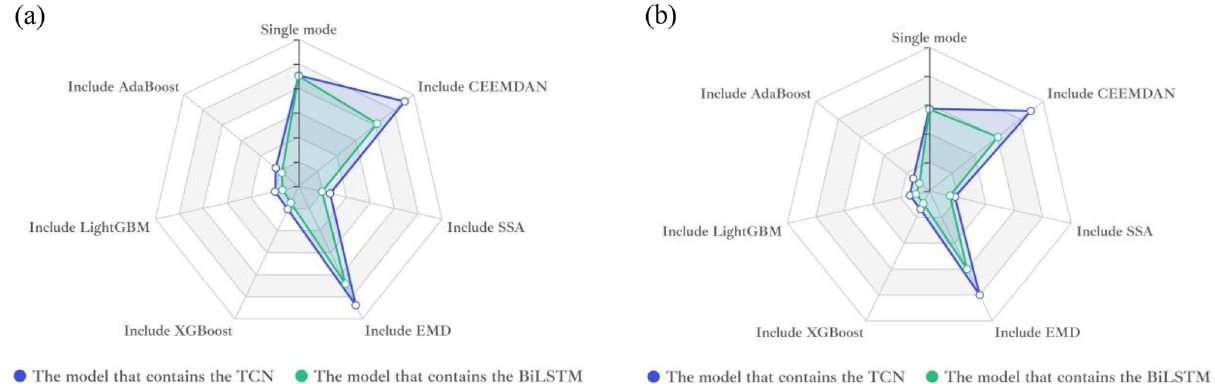
Figure 12. The comparison results of model’s evaluation indicators: ( a ) RMSE; ( b ) MAE.